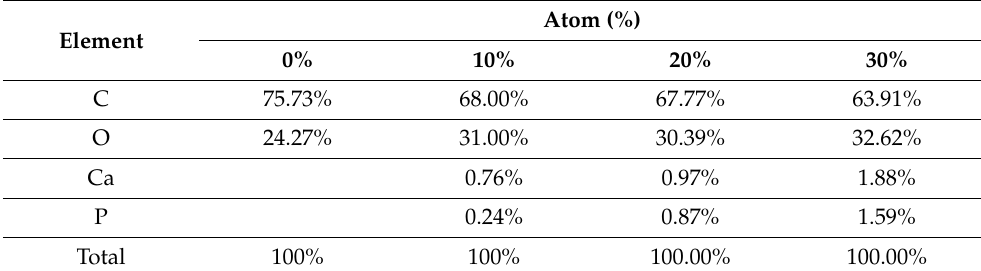
Table 3. Summary of EDX test results of PLA/PCL/nHA biocomposites.